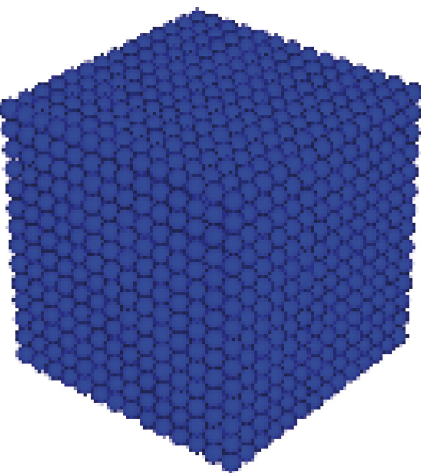
Figure 2: Regular arrangement